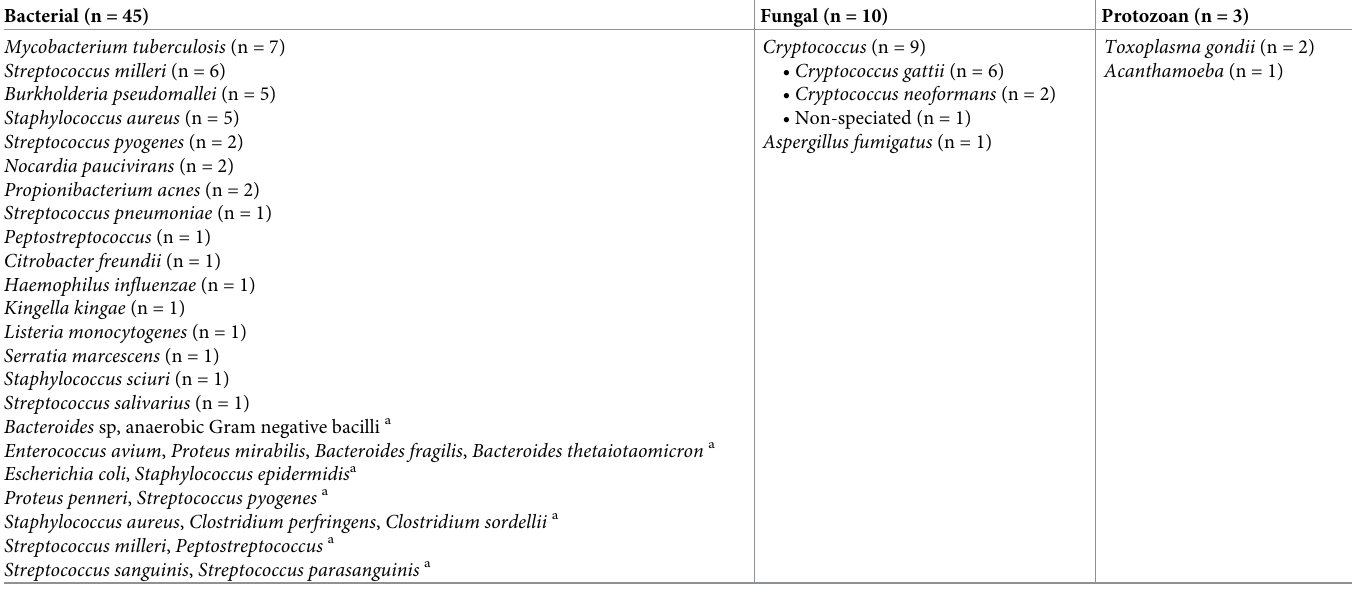
Table 7. Laboratory-confirmed aetiology of patients with brain